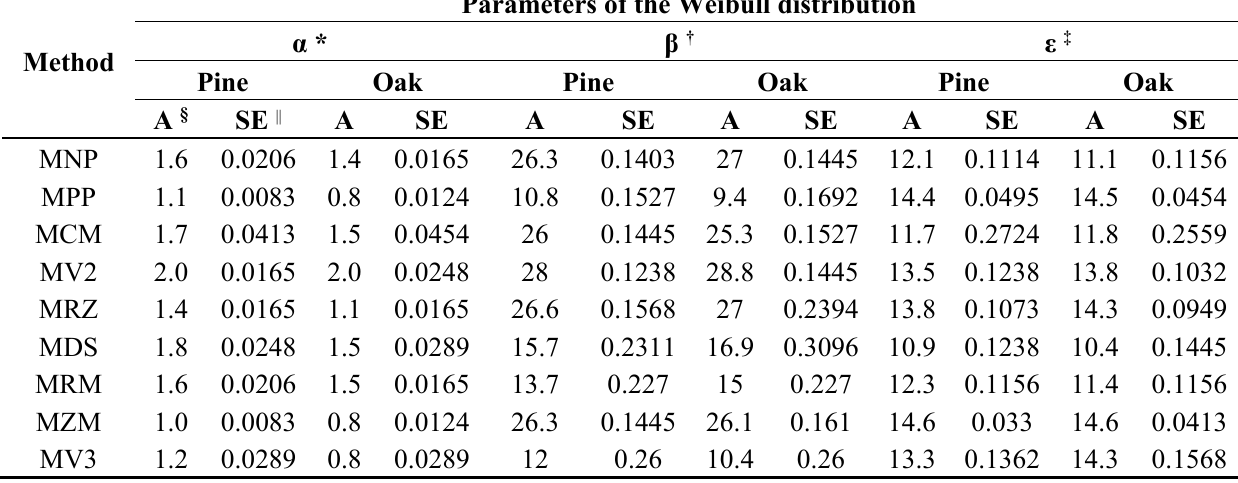
Table 2. Statistics of parameters calculated by nine techniques for 587 mixed forest stands of Durango, Mexico.